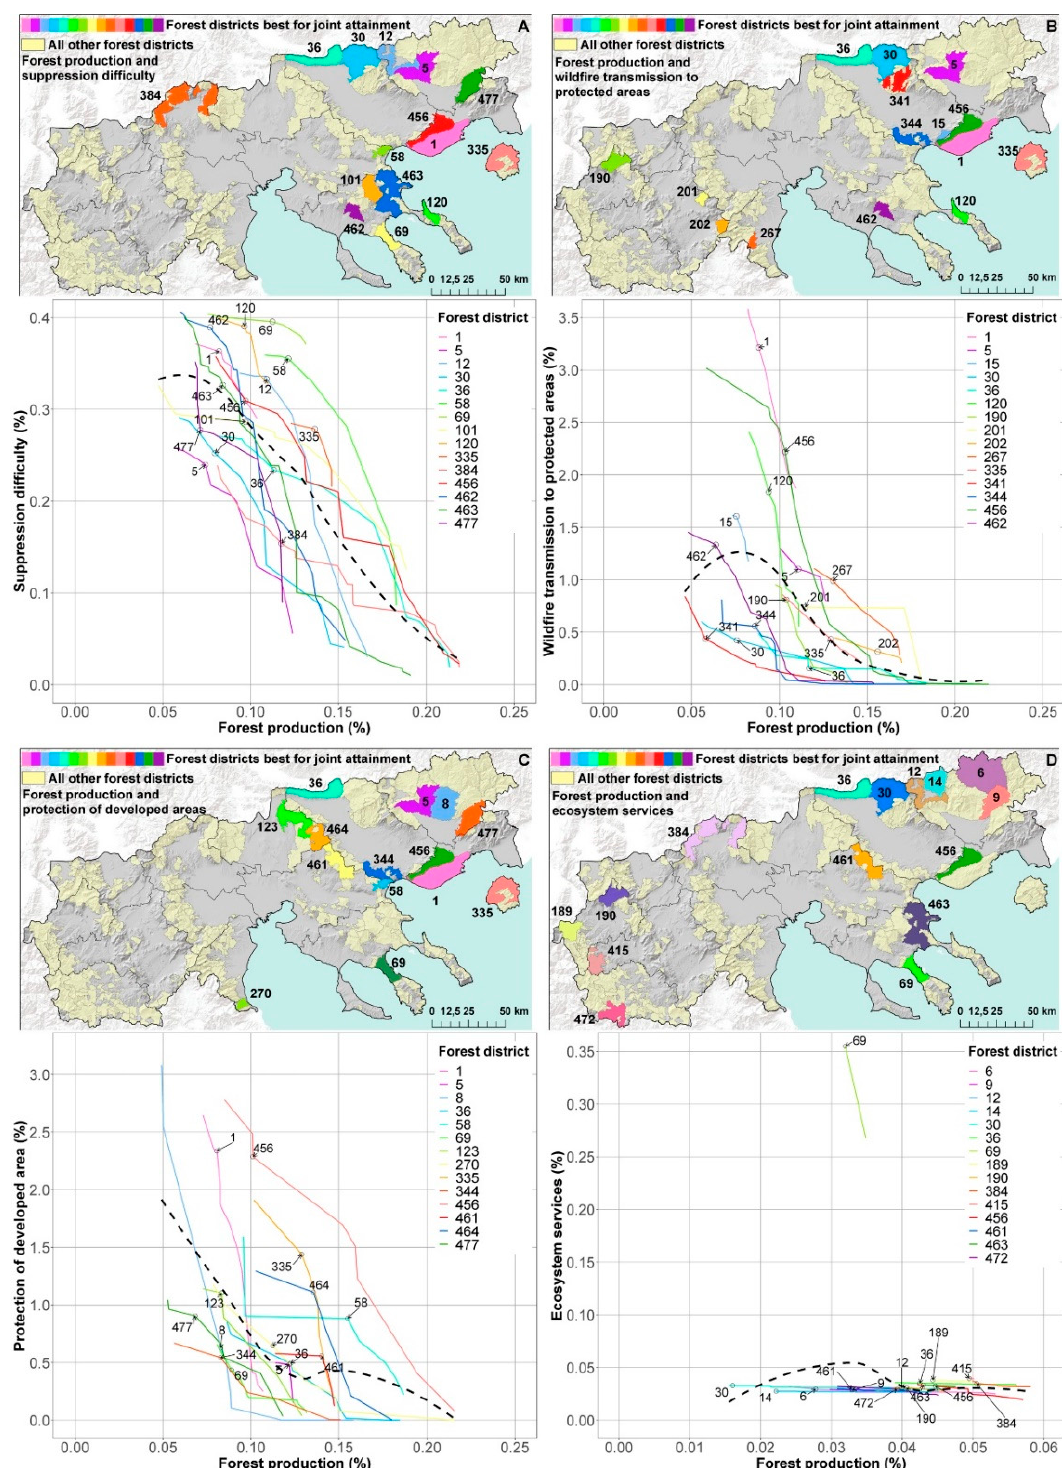
Figure 7. Tradeoffs between prioritizing projects for forest production versus each of the other four priorities. Maps show the top 15 forest districts in terms of joint production. Forest district attainment of: ( A ) forest production and suppression difficulty; ( B ) forest production and wildfire transmission to protected areas; ( C ) forest production and protection of developed area; ( D ) forest production and ecosystem services. Dashed curve represents a smoothed conditional mean of all lines estimated with the loess function.